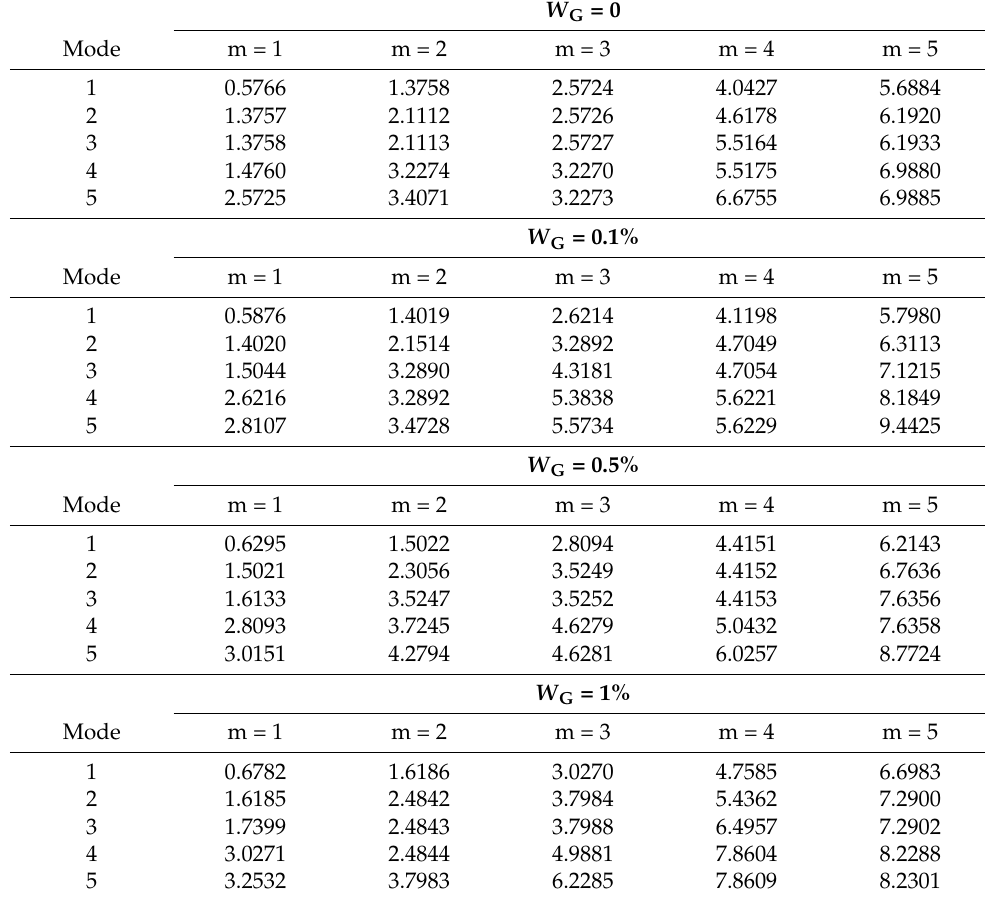
Table 2. Natural frequencies of the SSSS GPLs reinforced PMMA square plates for different GPLs weight